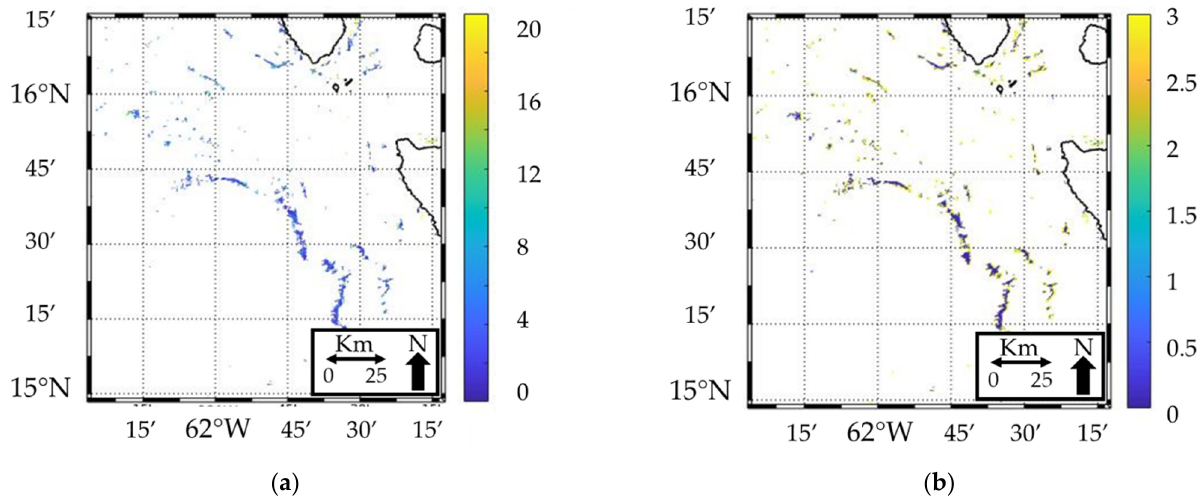
Figure 8. Spatial distribution of ( a ) FC (%) and ( b ) z retrieved by the SRT inversion method applied to the OLCI data acquired on 8 July, 2017, over the study area. Note that the data for which FC is lower than 0.1% and/or the depth is higher than 4.9 m were filtered out.